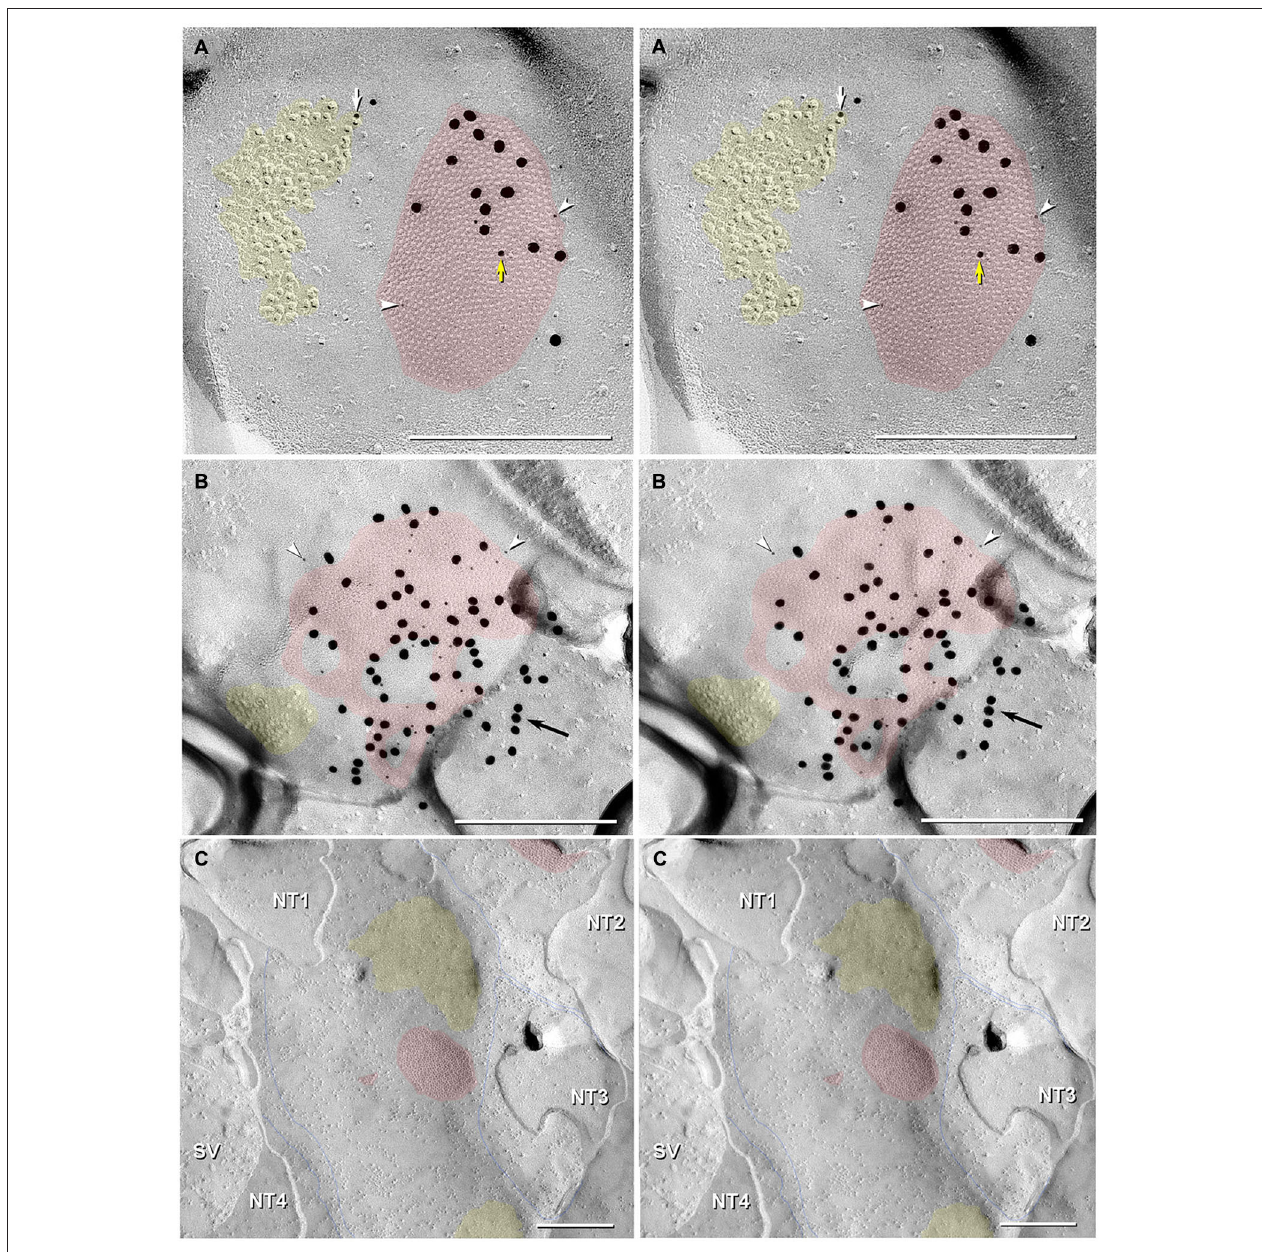
IMPs ( yellow overlay , not labeled) similar to other immunogold-labeled glutamate receptor channels. (C) P-face image showing three of more than a dozen unlabeled postsynaptic hemiplaques ( red overlays ) in the same replica as Figures 4 , 5B , where presynaptic hemiplaques are heavily labeled for Cx35 (P-Ser276). This absence of labeling in C is consistent with our demonstration in goldfish giant club ending/Mauthner cell mixed synapses that Cx35 is exclusively presynaptic and that Cx34.7 is exclusively postsynaptic (Rash et al., 2013). The postsynaptic P-face reveals distinct clusters of faintly resolvable pits ( yellow overlays ) where glutamate receptors had been removed during membrane splitting. Thin blue lines indicate probable margins of axon terminals impressed into the dendritic or somatic plasma membrane (NT1-NT4). SV = synaptic vesicles. Calibration bars are 0.25 µ